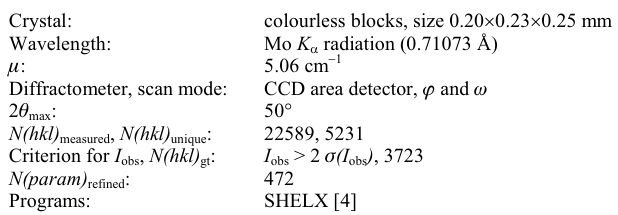
Table 1. Data collection and handling.